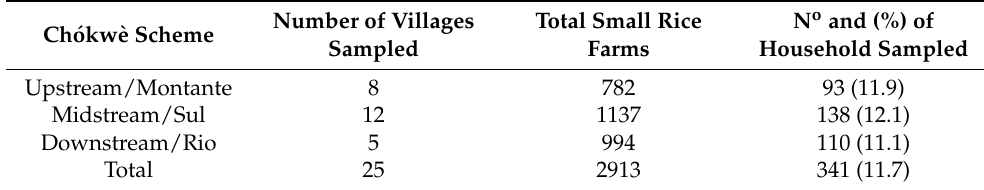
Table 1. Total number of smallholder rice farmers in the three main zones of the irrigation scheme, sample size and number of village samples per